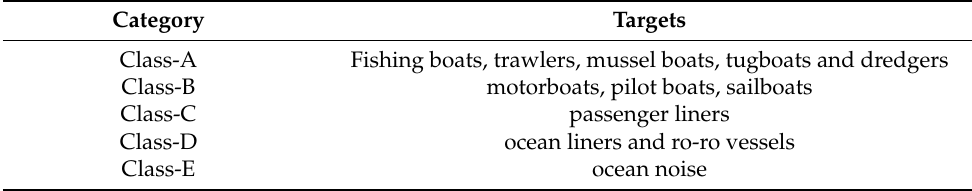
Table 4. Target category on